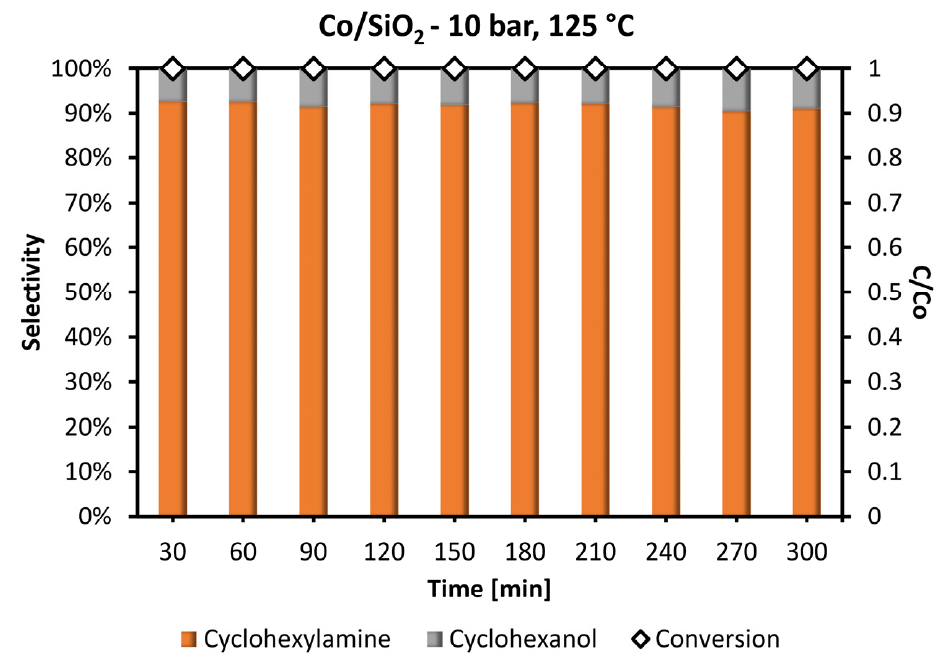
Figure 12. Stability test of Co/SiO 2 in catalytic hydrogenation of nitrocyclohexane in liquid flow conditions (10 bar, 125 °C).